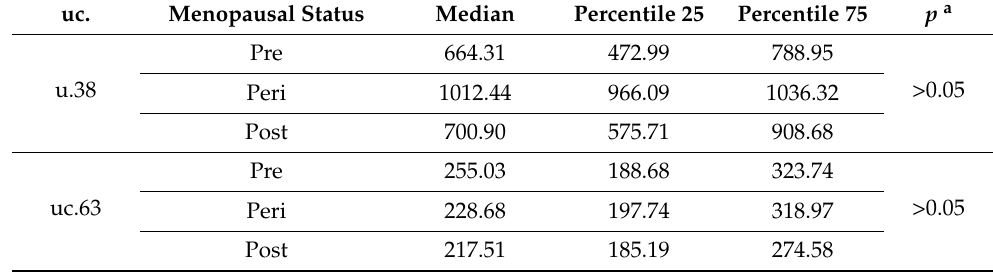
Table 5. Expression of uc.38 and uc.63 in breast ductal carcinoma patients and control.